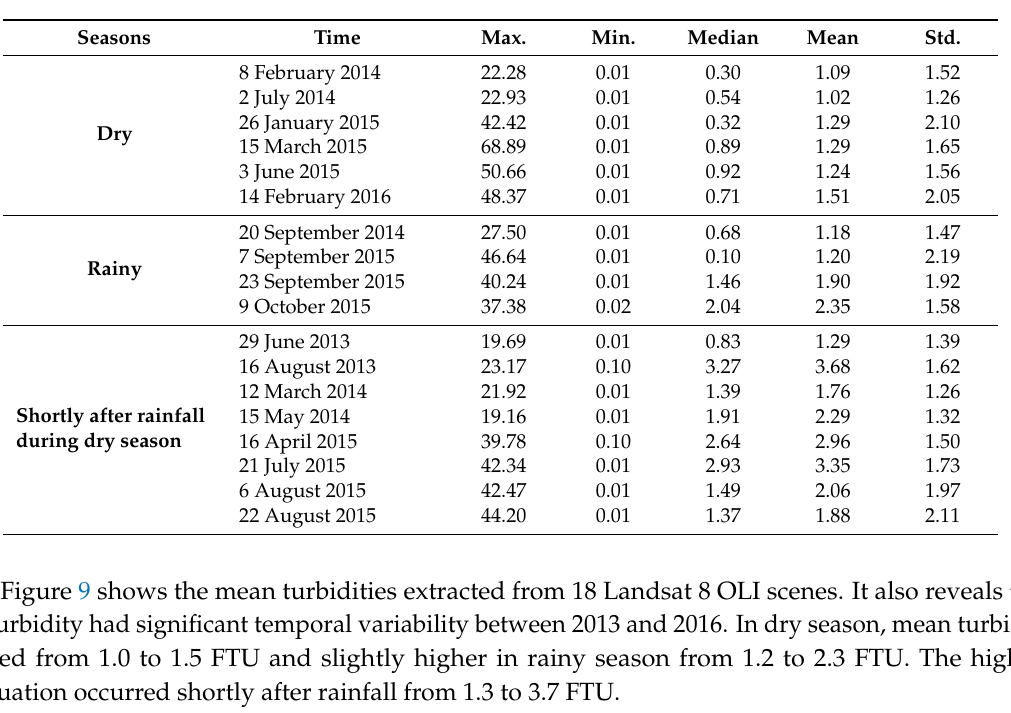
Table 7. Statistics of seasonal variation in turbidities across the bay and lagoon retrieved from Landsat 8 OLI images from 2013 to 2016.